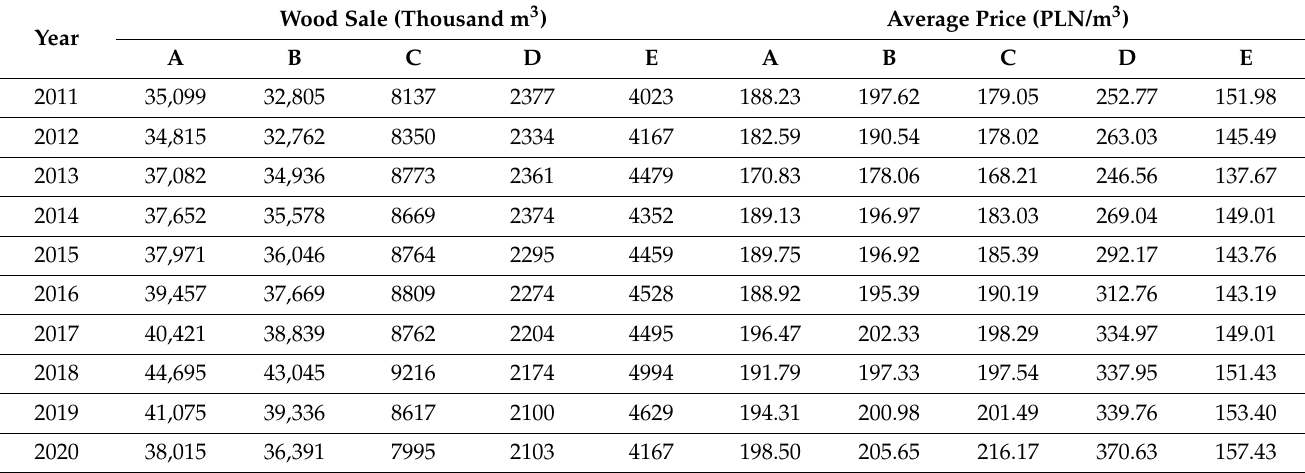
Table 2. Timber sales (thousand m 3 ) and average prices (PLN/m 3 ) in the period